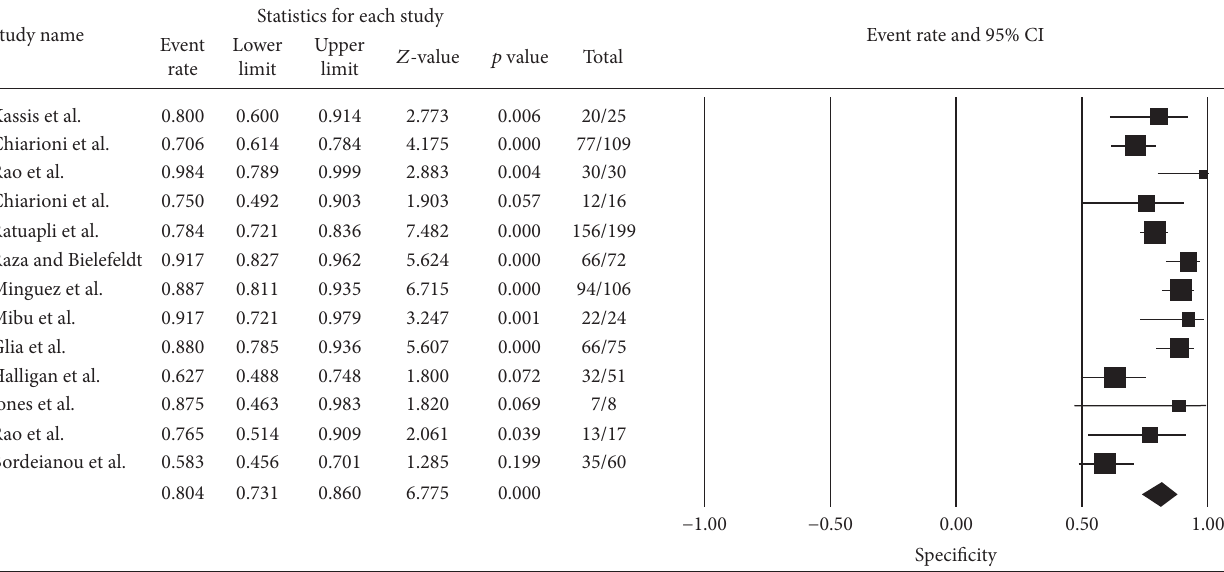
Figure 3: Summary measures for specificity of BET